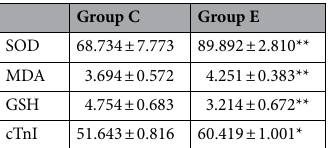
Table 1. Serum oxidative stress and myocardial injury markers in rats. ** p < 0.01 versus C group, * p < 0.05 versus C group.